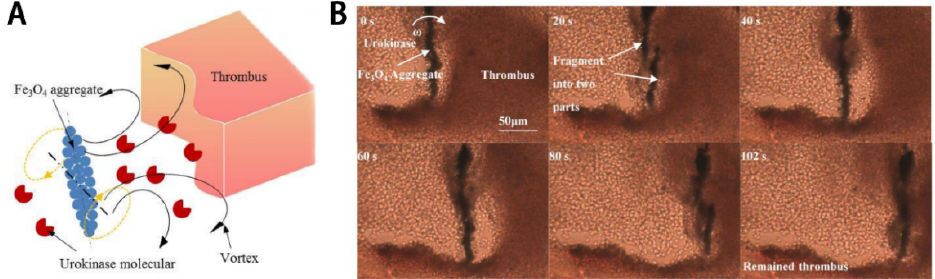
Figure 3. ( A ) The diffusion of urokinase is manipulated by the vortex induced by the rotation of rotating magnetic field (RMF)-guided aggregates. ( B ) Image sequences of thrombus removal by the RMF-guided Fe 3 O 4 NPs. Reproduced with permission [47]. Copyright 2018, MDPI.